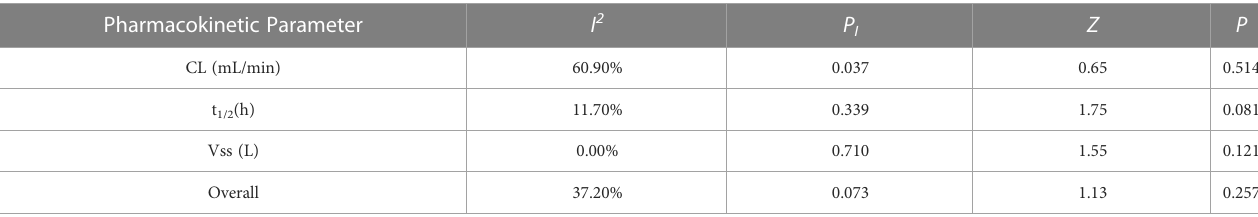
TABLE 7 Meta-analysis of pharmacokinetic parameter by heterogeneity test.